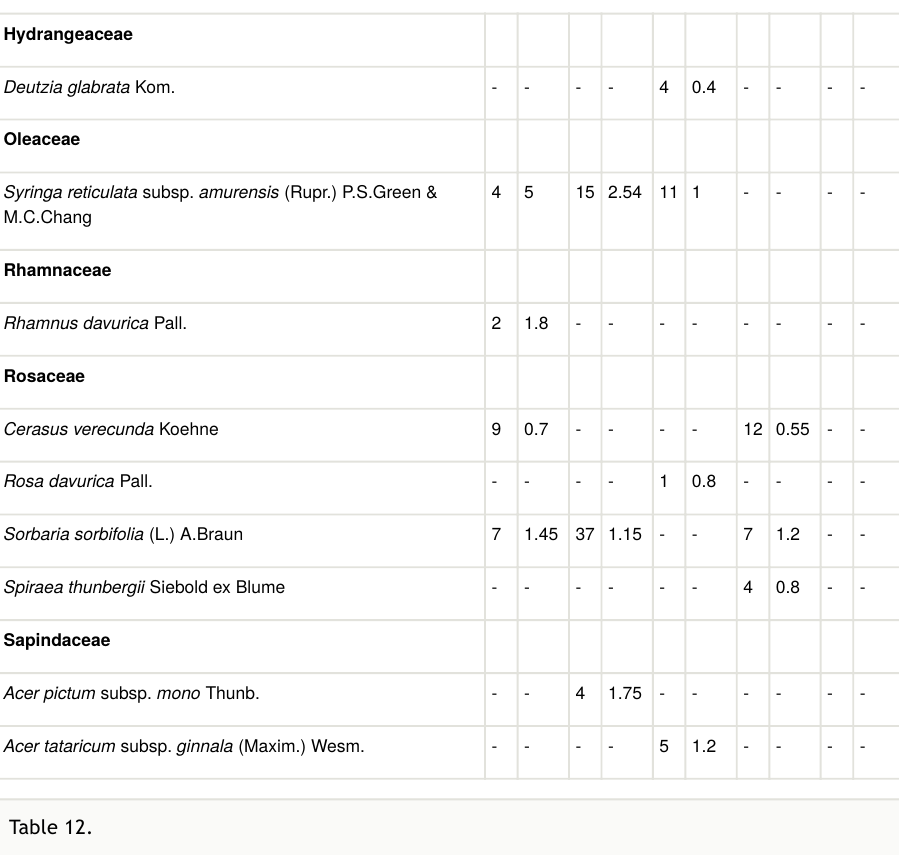
Table 12. The characteristics of herb community of fi ve forest types in Liangshui National Natural Reserve, where: UPF = Ulmus davidiana var. japonica—Pinus koraiensis forest; BPF = Betula costata